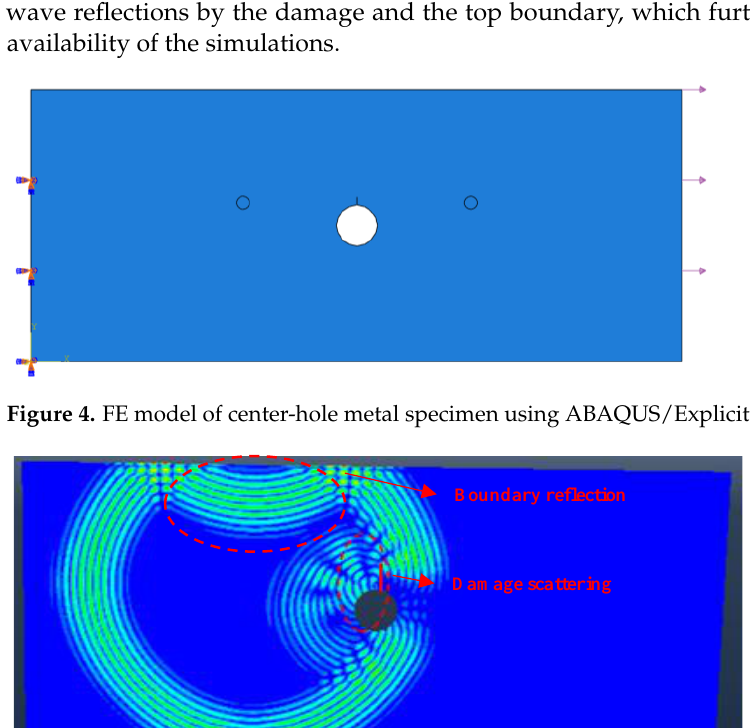
Figure 3. Specimen geometry and PZT sensors placement.